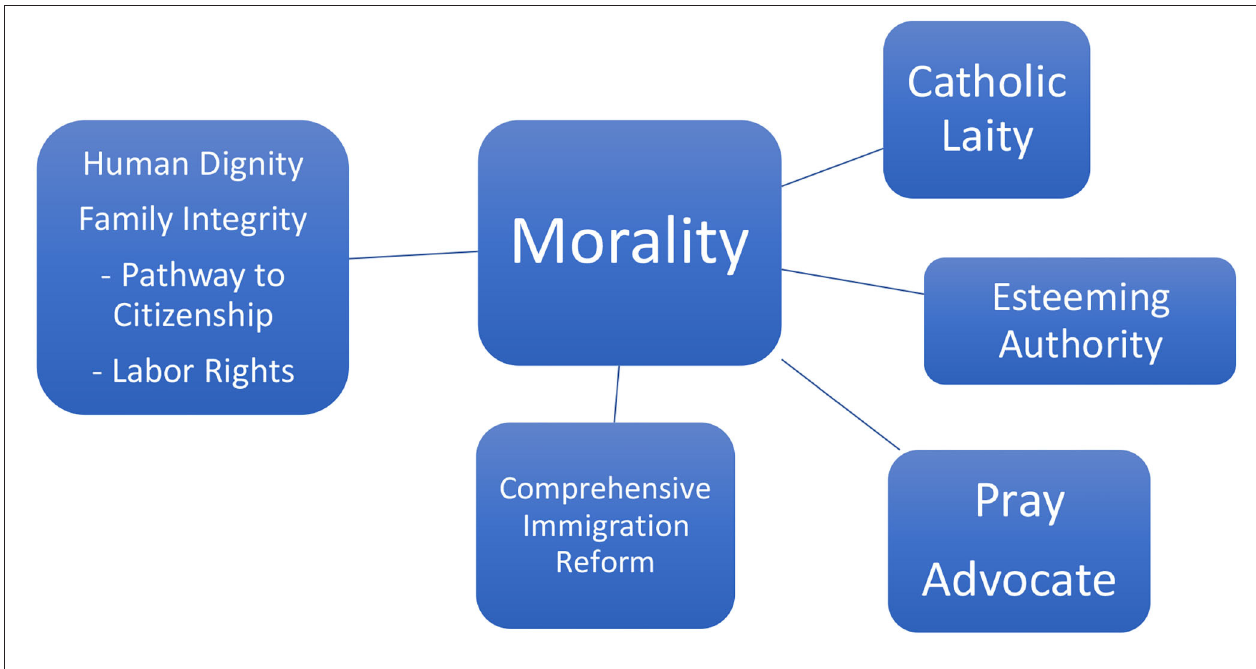
FIGURE 2 | Positive cluster.